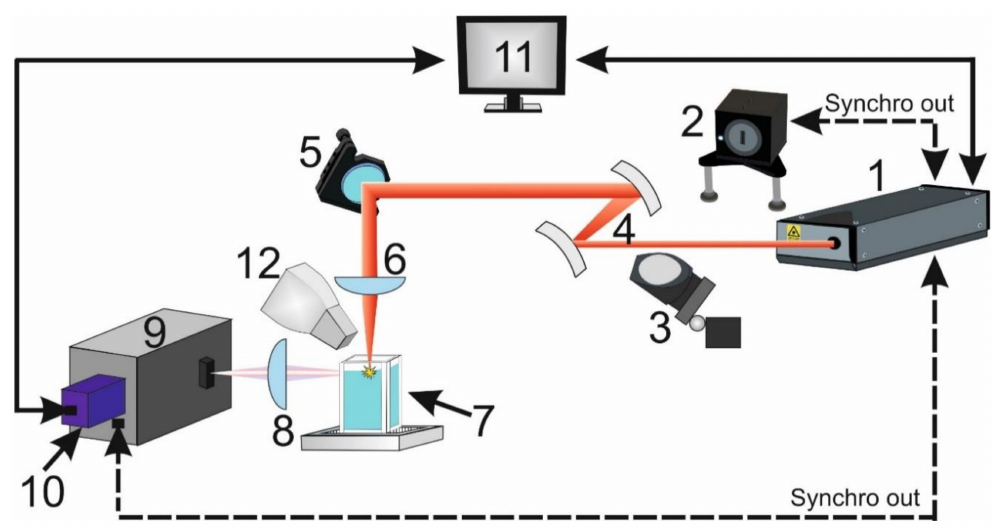
Figure 4. Femtosecond laboratory setup. 1 — Tsunami + Spitfire 40f-1k-5W femtosecond laser